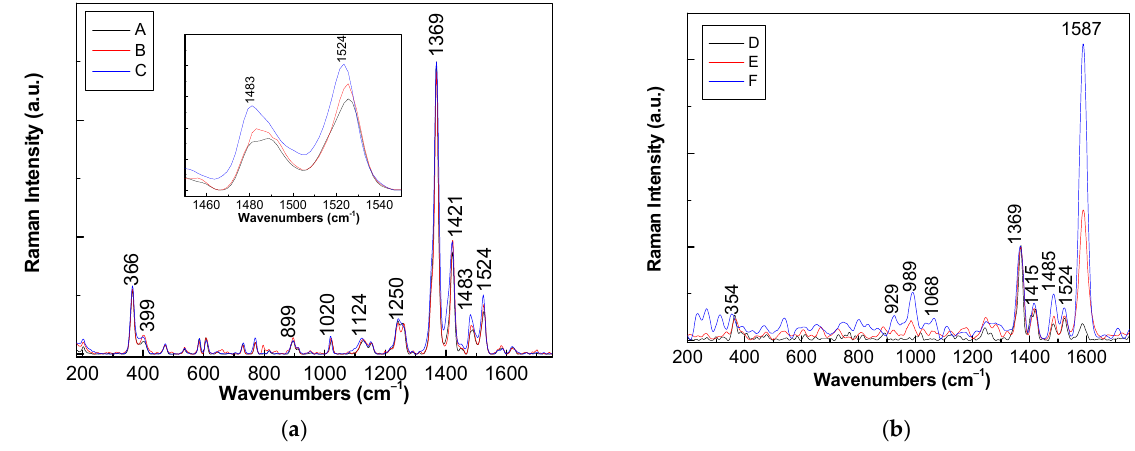
Figure 3. Raman spectra of the POPD-PVDF blends labeled as samples A (black curve, a ), B (red curve, a ) and C (blue curve, a ) as well as the POPD-PVDF/DWNTs composites labeled as samples D (black curve, b ), E (red curve, b ) and F (blue curve, b ).